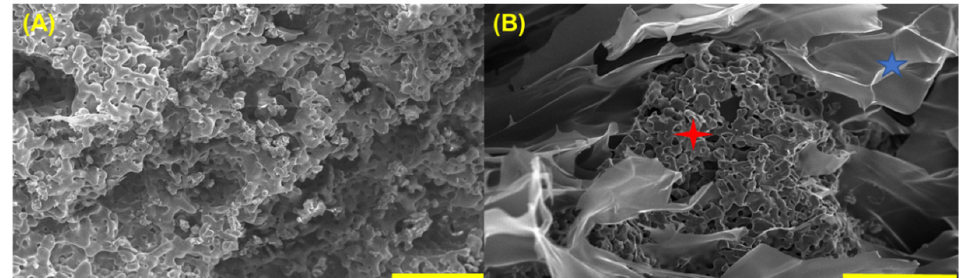
and the blue star indicates gelatin sponge. The yellow scale bar represents a length of 50 μ m.